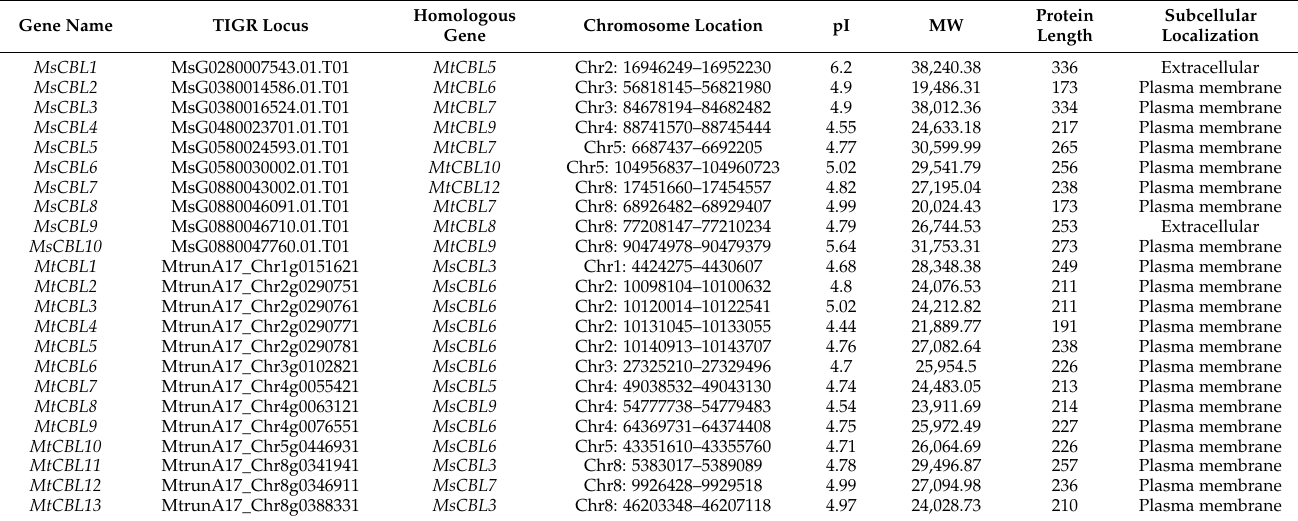
Table 1. Properties of the predicted CBL proteins in M. sativa and M. truncatula.